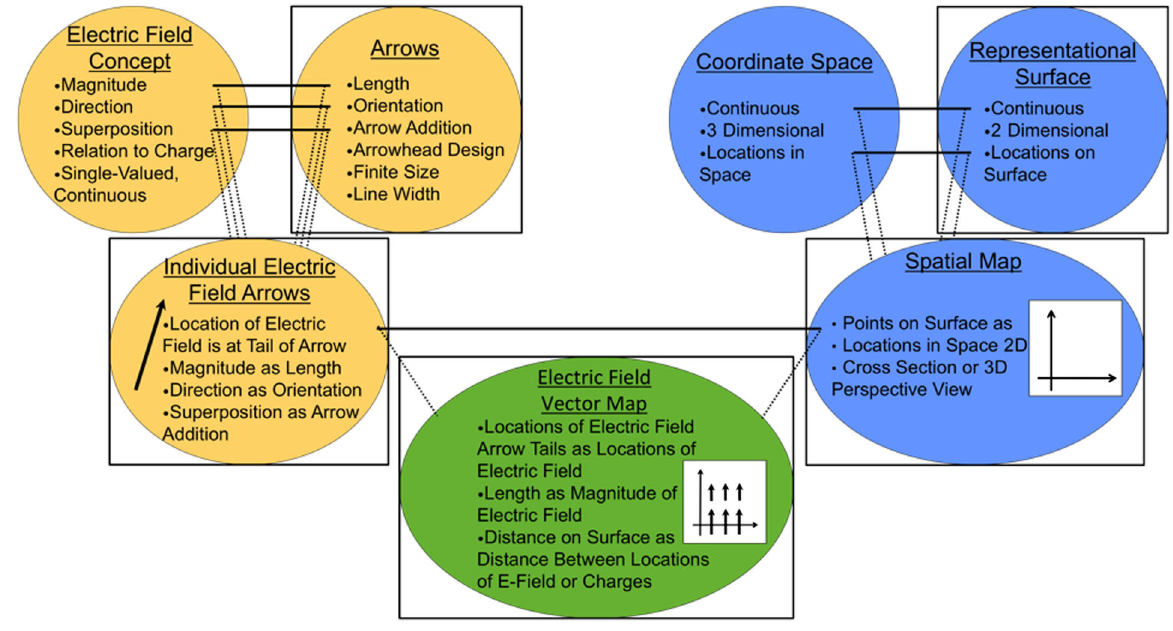
FIG. 2. Network for the double scope electric field vector map blend. The electric field vector map is a blend of the individual electric field arrows and spatial map input spaces, which are each blends of other input